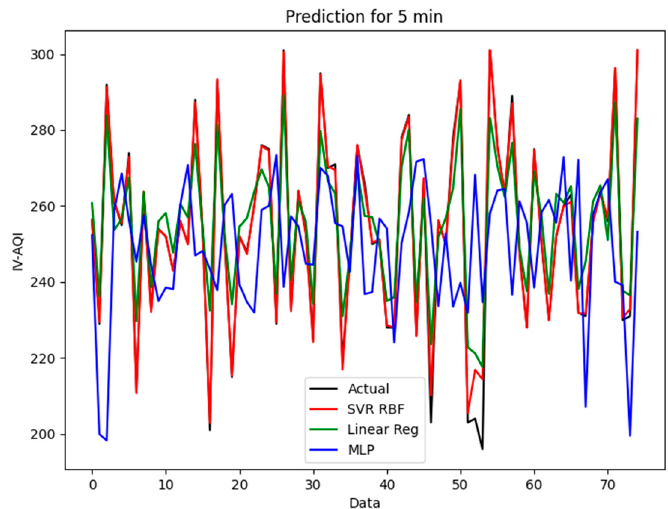
Figure 9. The prediction for the section event in SVR, LR, and MLP.